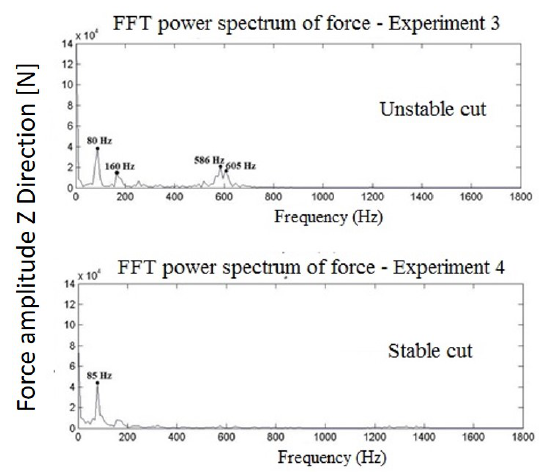
Fig. 10. FFT power spectrum of experiments 1,